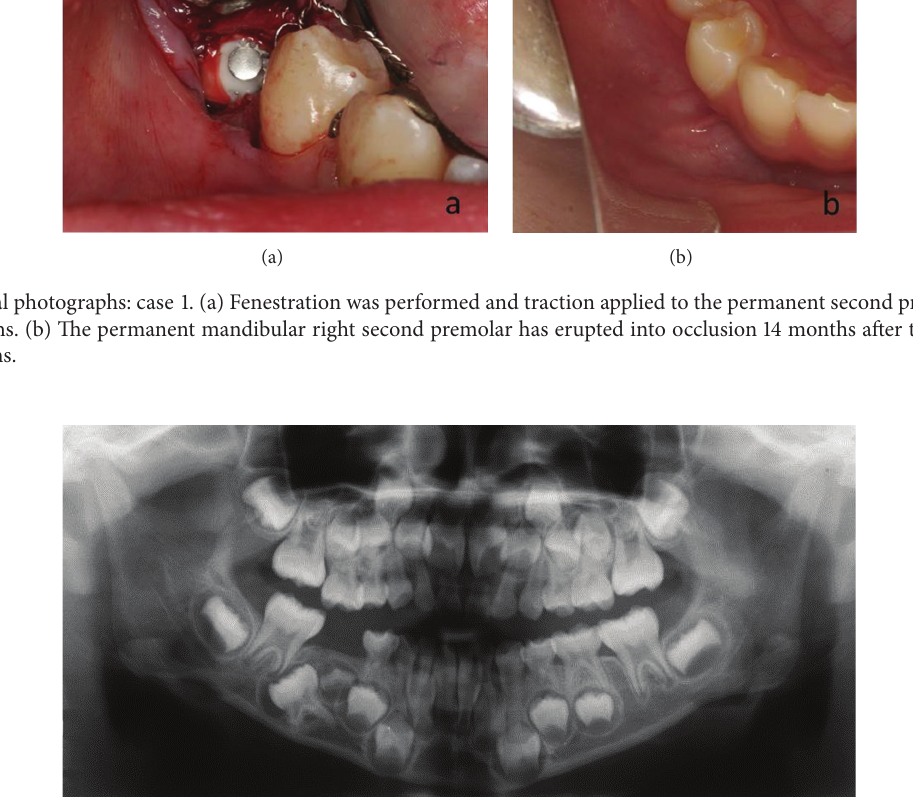
Figure 4: Initial panoramic radiograph: case 2. Complete impaction and distal inclination of the mandibular right second primary molar in the mandibular bone.